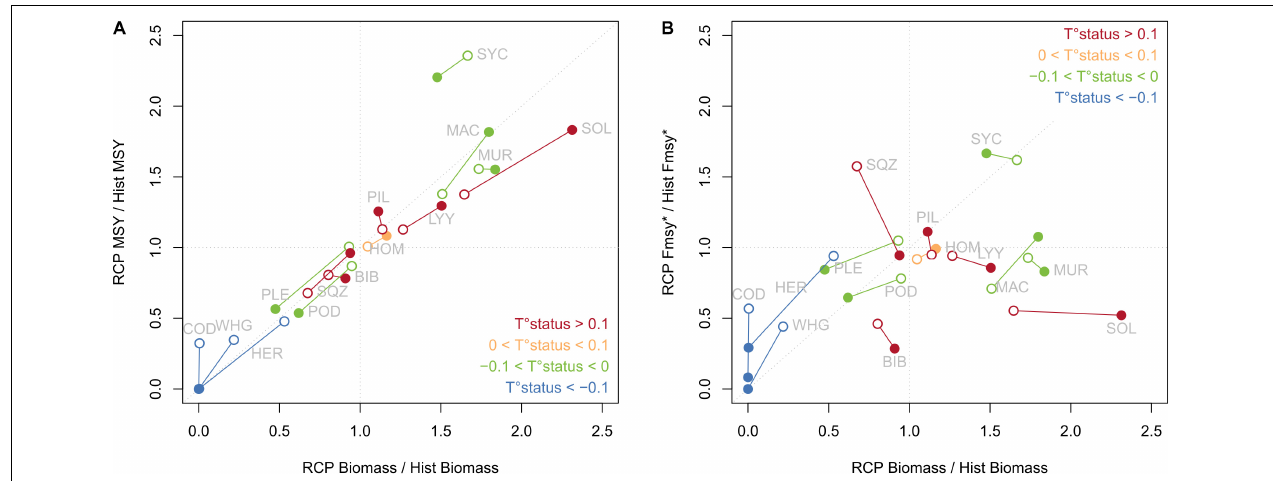
FIGURE 2 | Evolution of MSY (A) and F MSY * (B) (corresponding to F MSY for most species, and to F 95 MSY for species displaying a plateau in their catch-F curve) under RCP 4.5 (open dots) and RCP 8.5 (filled dots) compared to historical values. Color of the dots indicates the T ◦ status of the species. Species code name are explicit in Table 1